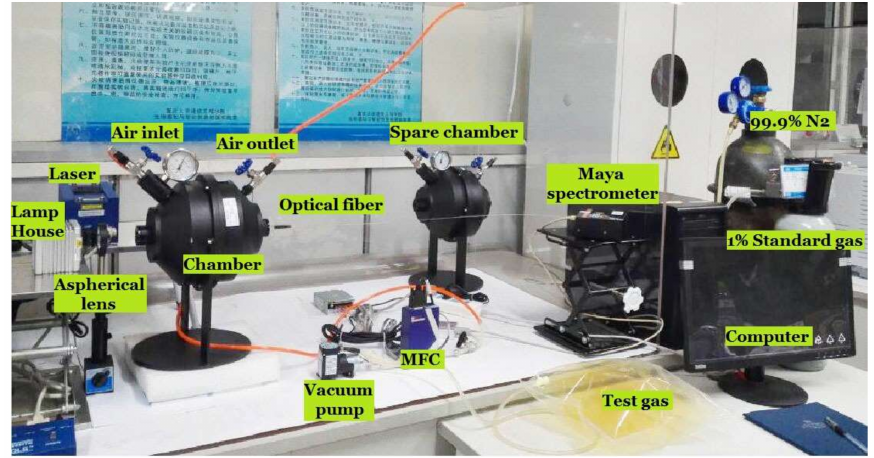
Figure 4. Experiment platform of light absorption gas detection